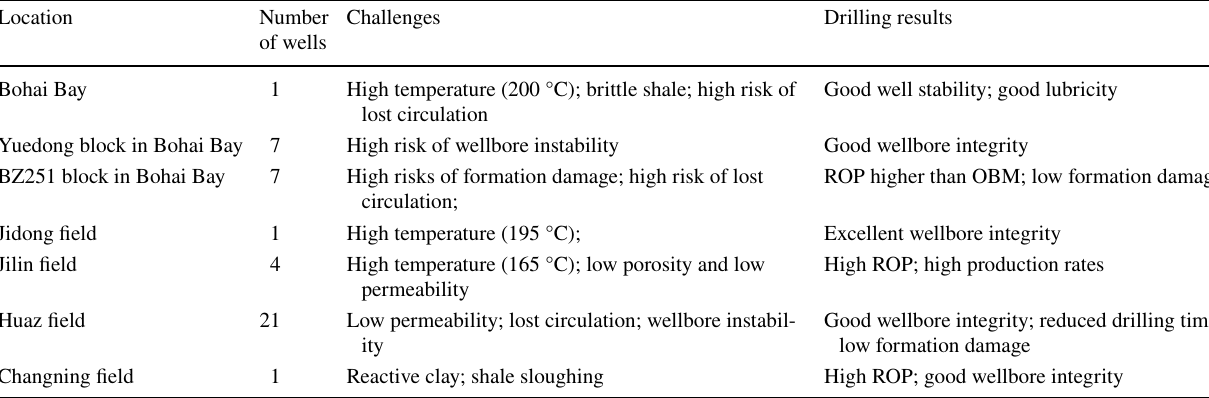
Table 14 Summary of field cases with glycol mud